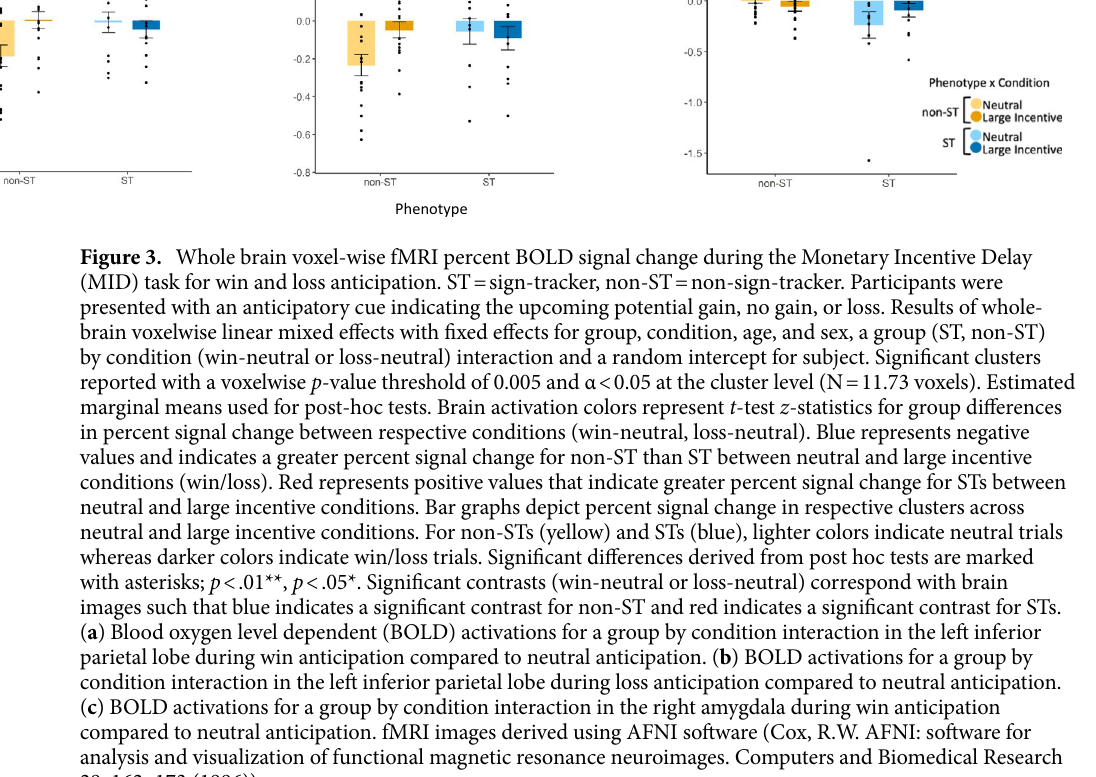
control (Supplementary Table S5) which may indicate that, in comparison to non-STs, STs do not actively engage cognitive control and the salience of the cue is cognitively irrelevant.